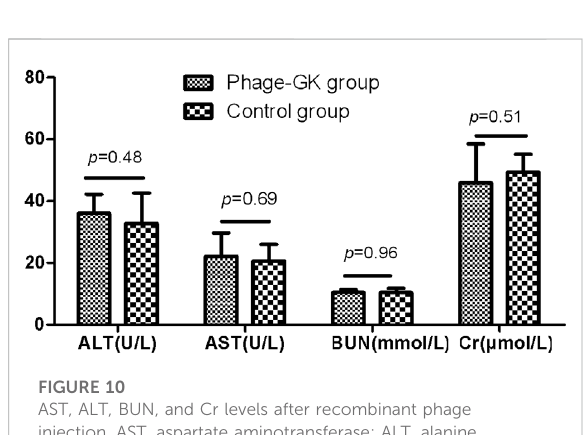
FIGURE 9 Survivalrate of S. globosa-infected micetreated withPG,ITR, WT,orPBSalone.WT:wild-type phageinjection;ITR:itraconazole injection; PG: phage-GK injection.